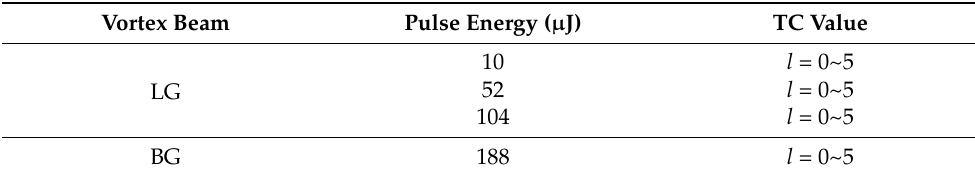
Table 2. Parameters of the LG and BG beams used in our experiment.